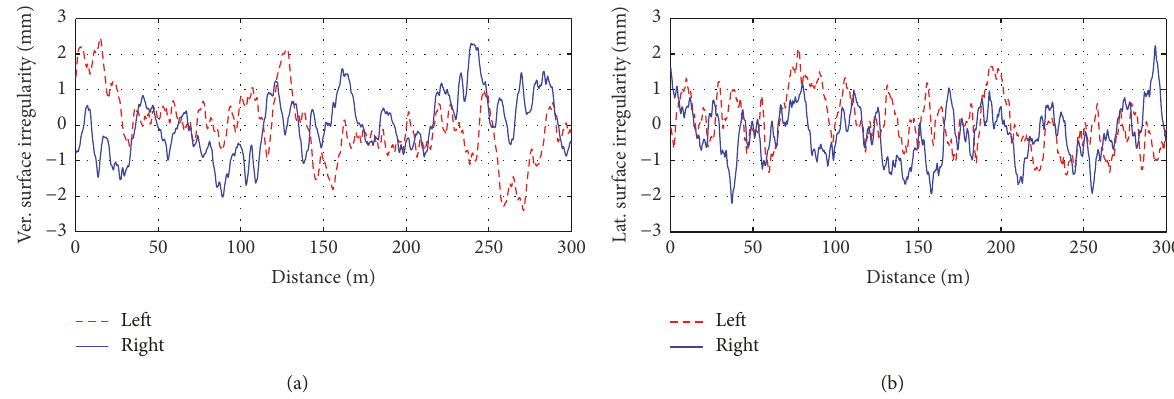
Figure 3: Surface irregularity profiles generated from PSD function: (a) vertical surface irregularities of the right and left reaction plate, (b) lateral surface irregularities of the right and left reaction